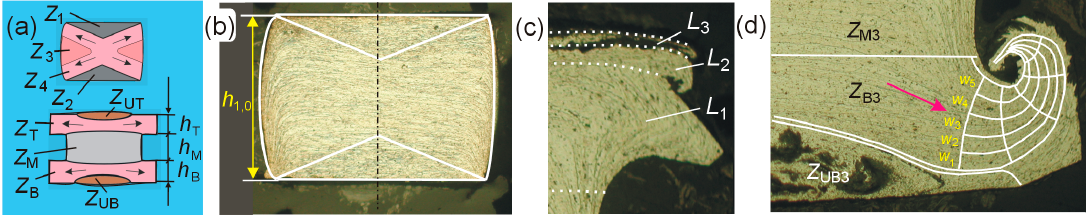
Figure 13. ( a ) Areas with diverse plastic features; ( b ) metallographic cross-section of S1 after simple upsetting; ( c ) close up q1of Figure 6a; close-up q2 of Figure 6a.